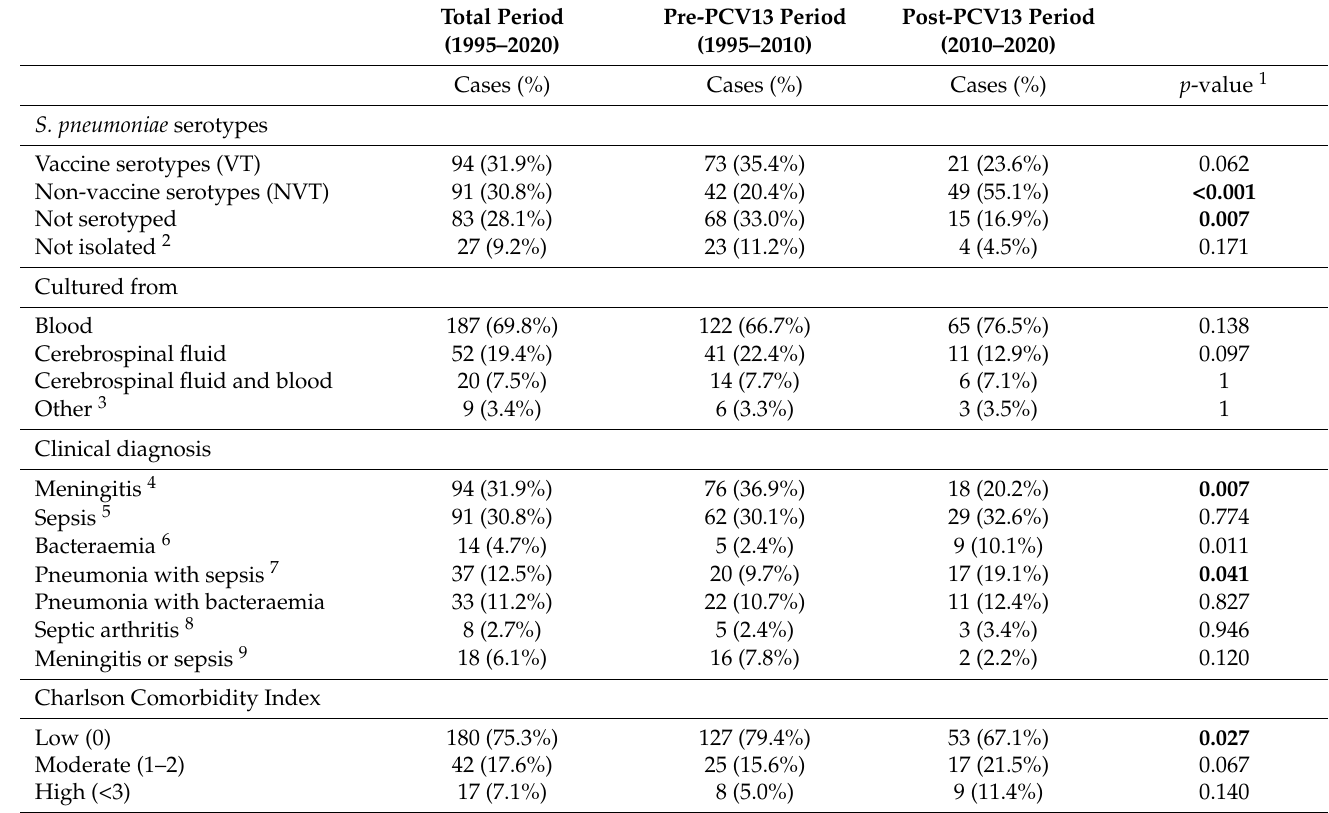
Table 2. Microbiological and clinical findings in 295 patients with invasive pneumococcal disease (IPD) in Greenland 1995–2020, overall, pre (1995–2010), and post (2010–2020) introduction of the 13-valent pneumococcal conjugate vaccine (PCV13) to the childhood vaccination program in 2010 in